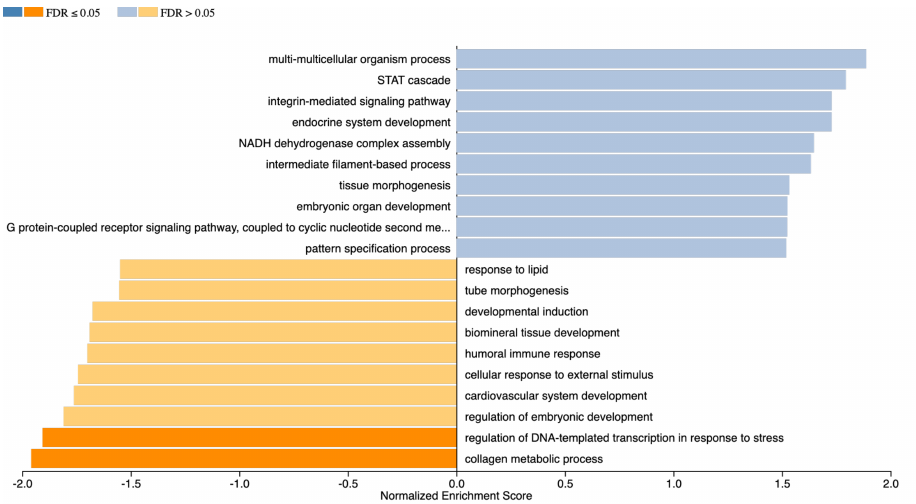
Figure 12. Enrichment analysis bulk RNAseq Enrichment analysis of all the NPs over the AFs bulk RNAseq data. GSEA, GO terms Biological Process. The bar chart shows a significant enrichment of the collagen metabolic process and DNA response to stress in the NPs over the